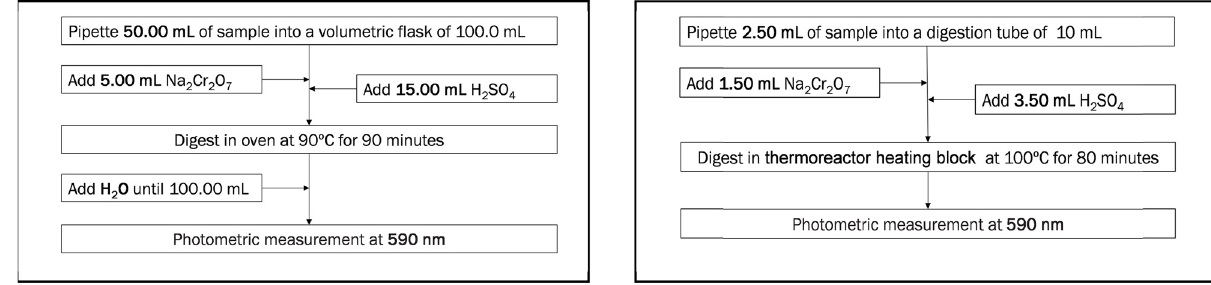
Figure 1: Analytical procedure of Method 1 ( left ) and Method 2 ( right )